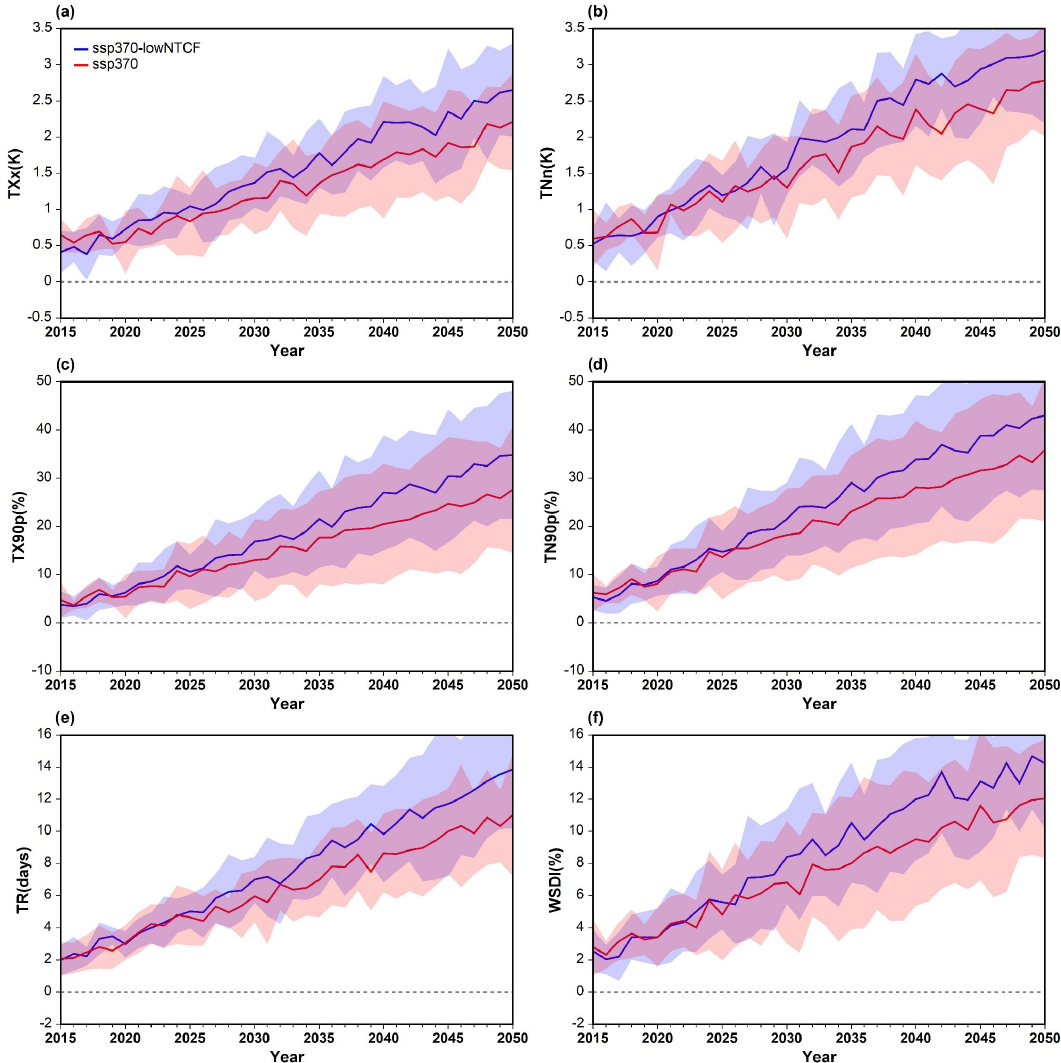
Figure 6. Time series of changes in annual mean for the hottest day (TXx; a ), coldest day (TNn; b ), warm days (TX90p; c ), warm nights (TN90p; d ), tropical nights (TR; e ), and warm-spell duration (WSDI; f ) averaged over Asia under the SSP3-7.0 (red) and SSP3-7.0-lowNTCF (blue) scenarios from 2015–2050 relative to 1995–2014. The red and blue shading represents the ± 1 standard deviations across